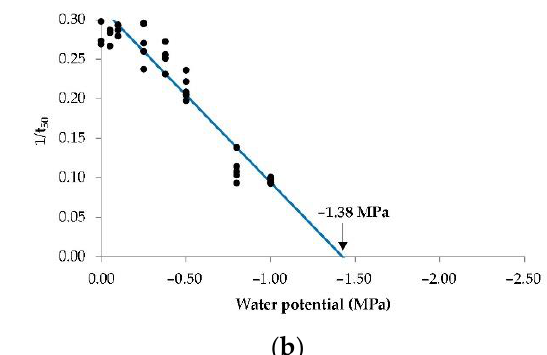
Table 2. Germination dynamics at different water potentials (MPa) at 22 °C . Differences between the initial (t 10 ), medium (t 50 ), and final (t 90 ) germination under different water potentials according to one-way analysis of variance (ANOVA). Different small letters (a–d) within a column indicate a statistical difference according to Fisher’s Least Significant Difference (LSD) test at p < 0.05.